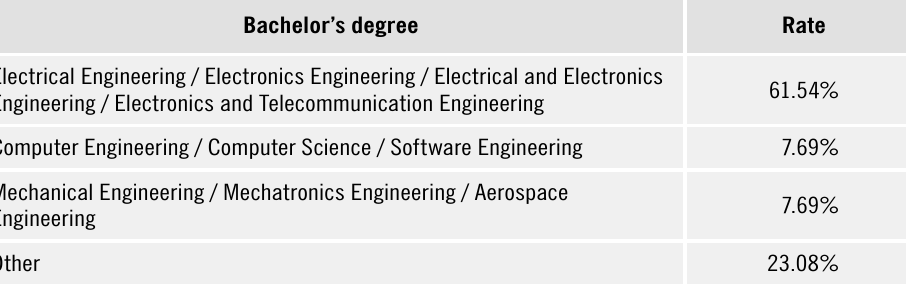
Table 3. Bachelor’s degree of cofounders of the respondent companies